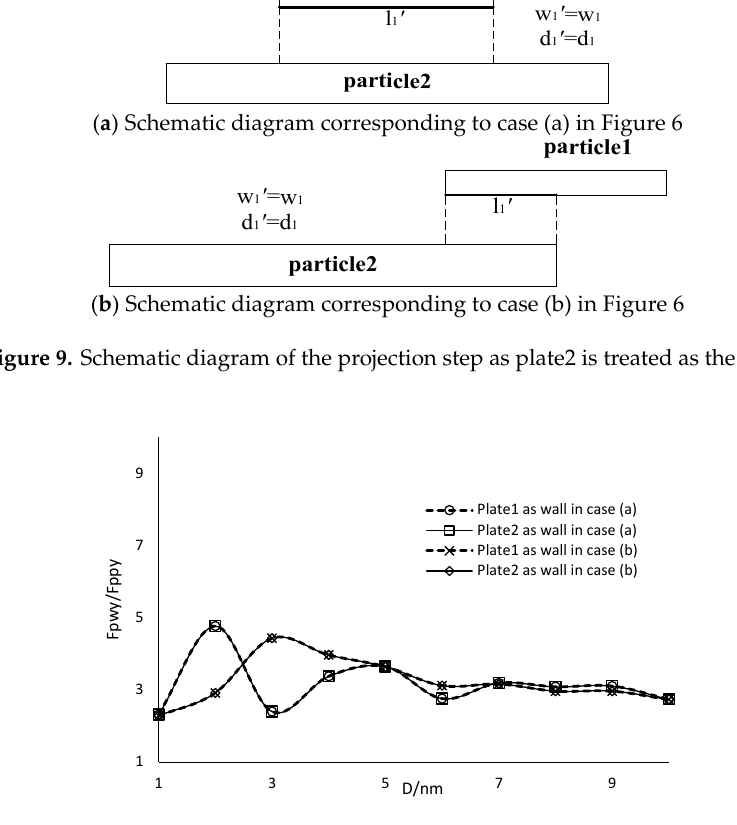
Figure 10. Comparison of the calculated force of different choices based on projection procedure.